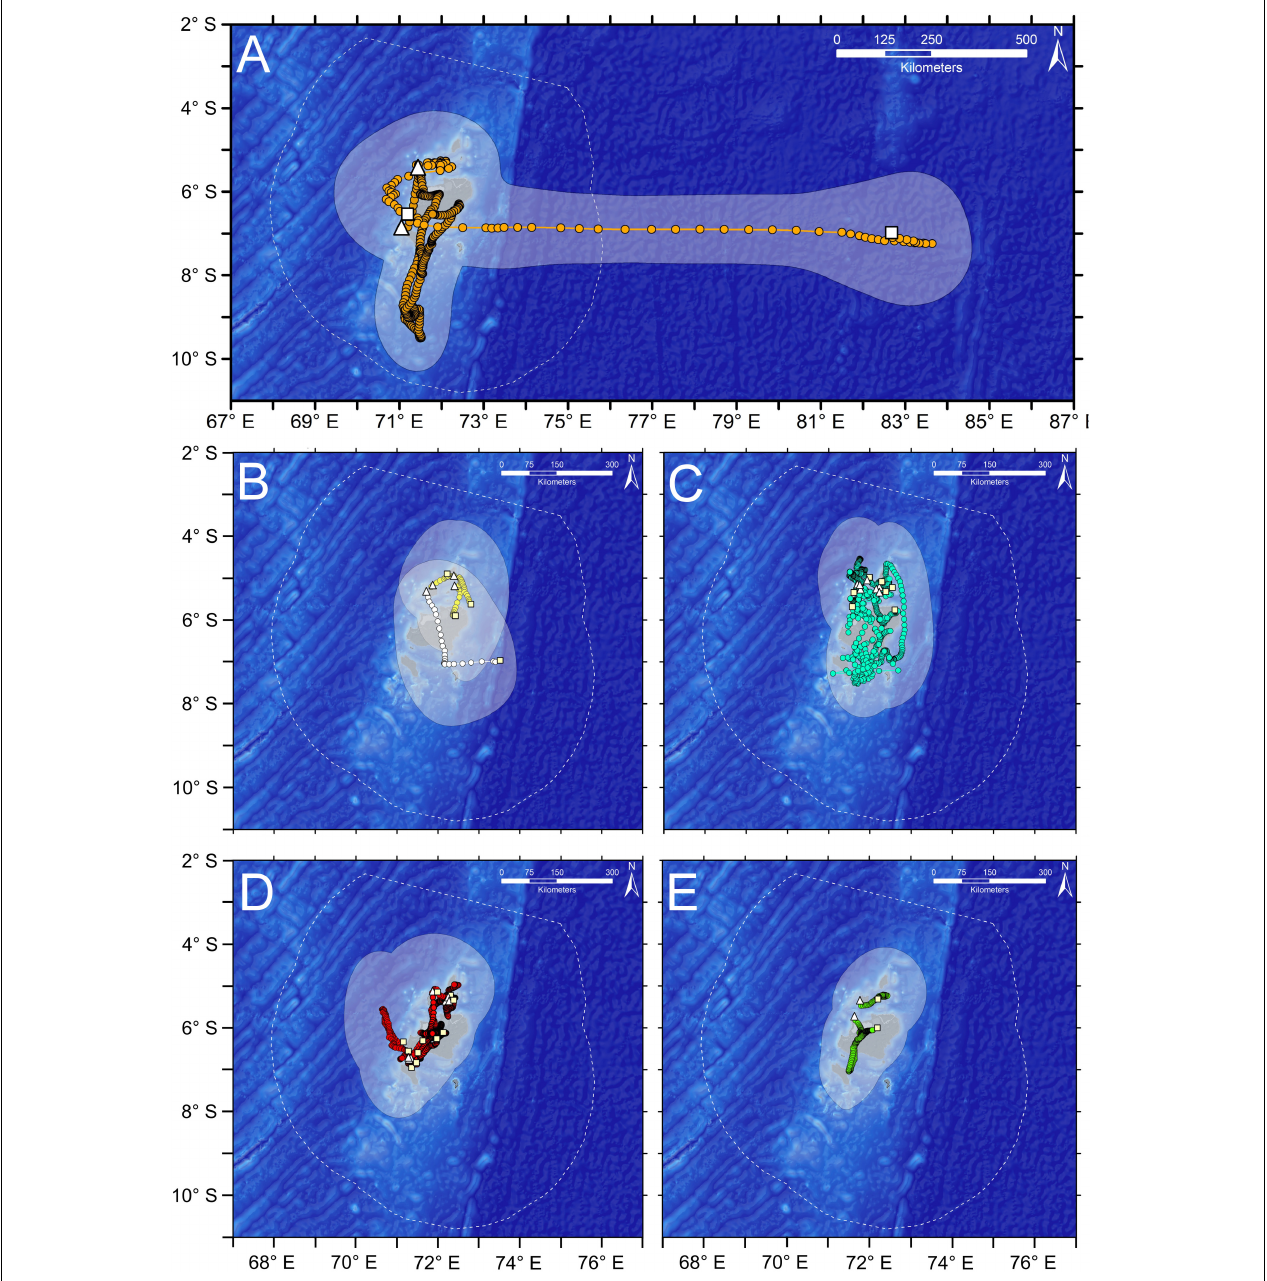
FIGURE 2 | State space model tracks, and 95% KUD (shaded polygon) of full posterior distribution of estimated positions from SSM model for satellite-tagged pelagic fishes and elasmobranchs in BIOT MPA. Tagging location is indicated with the white triangle, pop-up position with white square. Boundary of the BIOT MPA is shown with the dotted white line. (A) Silky Sharks (SKY, n = 2), (B) Blue Marlin (BLM, white, n = 1) and Yellowfin Tuna (YFT, yellow, n = 3), (C) Silvertip Sharks (STP, n = 7), (D) Reef Mantas (MAN, n = 11), and (E) Sailfish (SAI, n =